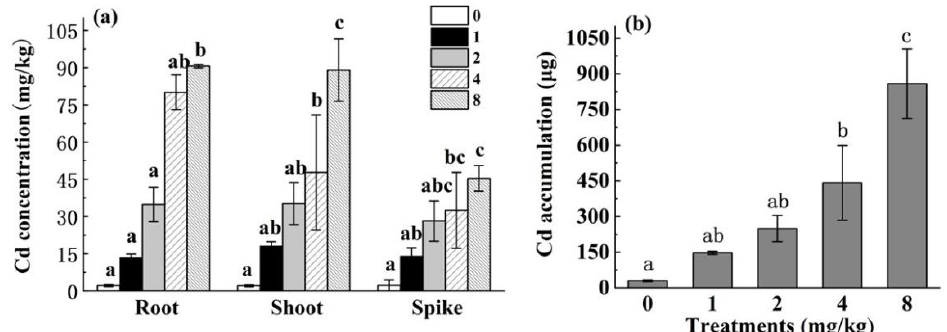
Figure 2. Cd concentrations of all parts of the sea rice ( a ) and its Cd accumulation ( b ). Lowercase letters on the bar chart indicate significant differences among different treatments ( p < 0.05). Data were presented as mean ± standard error (n = 3).